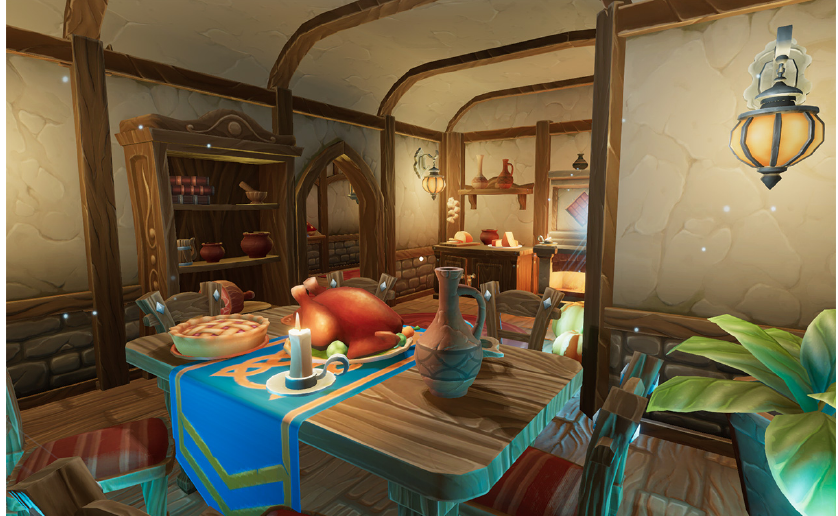
Figure 1. Screenshot of the game prototype that was used in the comparative study (first person